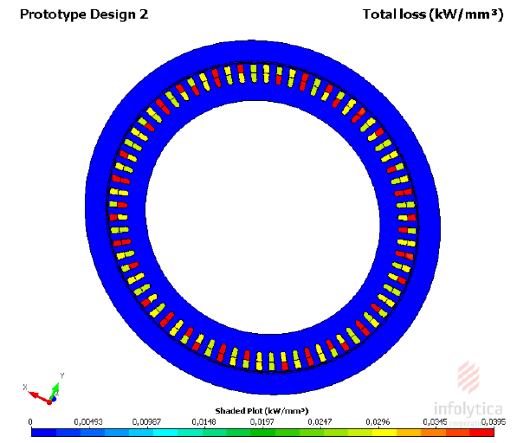
Figure 4. Total losses of modeling